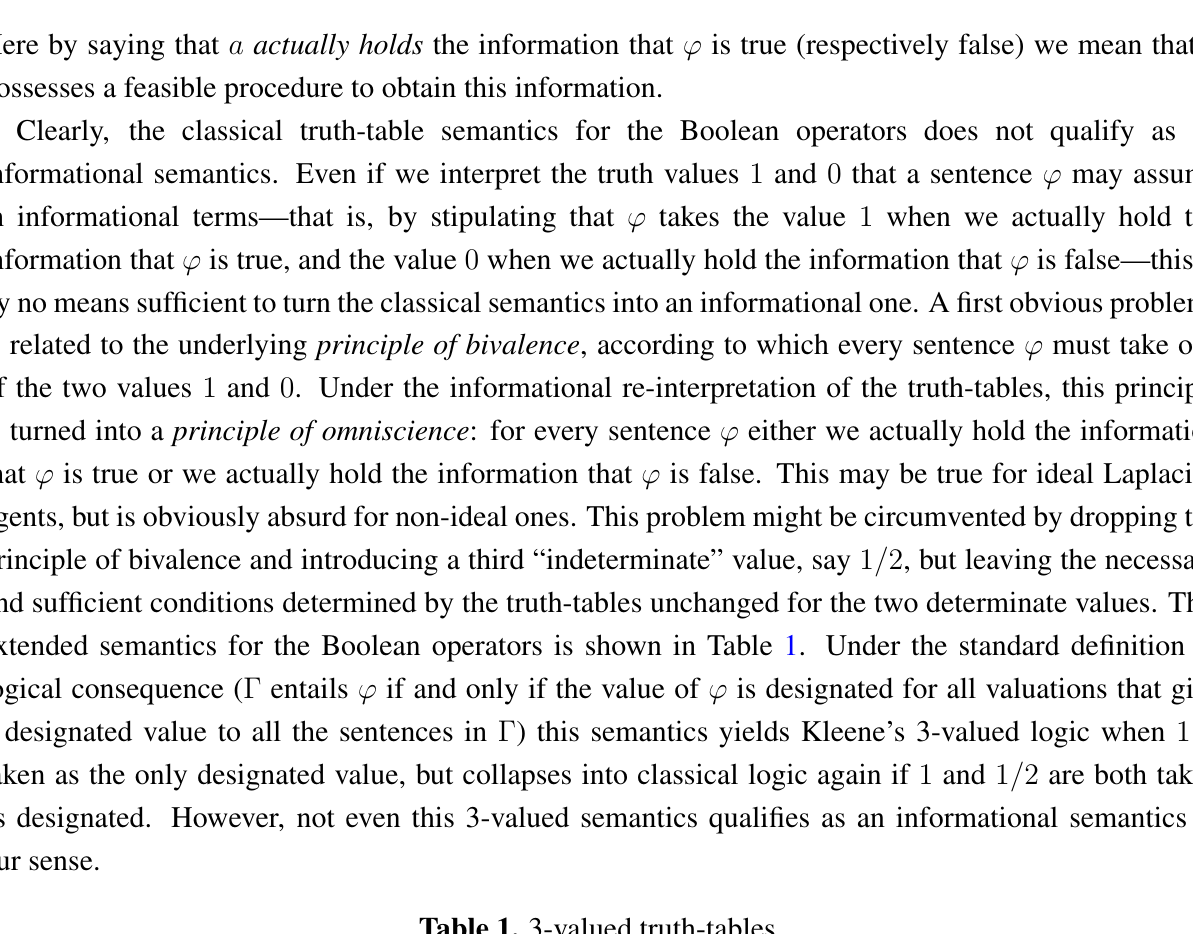
Table 1. 3-valued